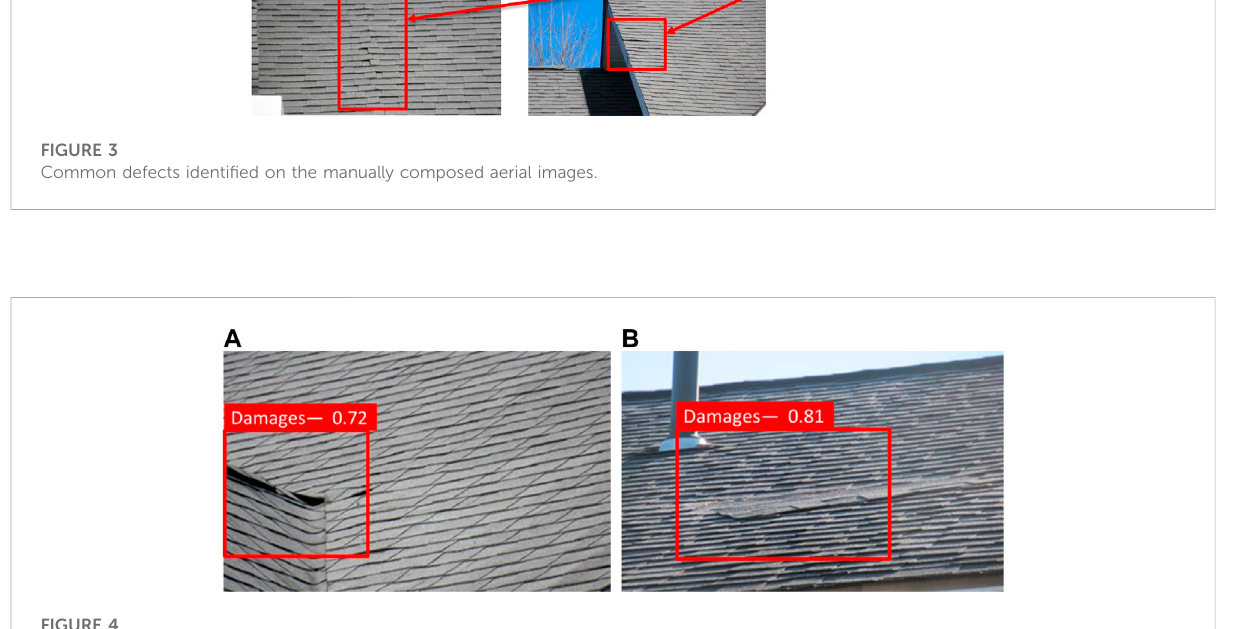
FIGURE 4 (A) (left)showstheaccuracyofthemodelforthetrainingphotos,whichis72%. (B) (right)showstheaccuracyofthemodelforvalidationphotos which is 81%.